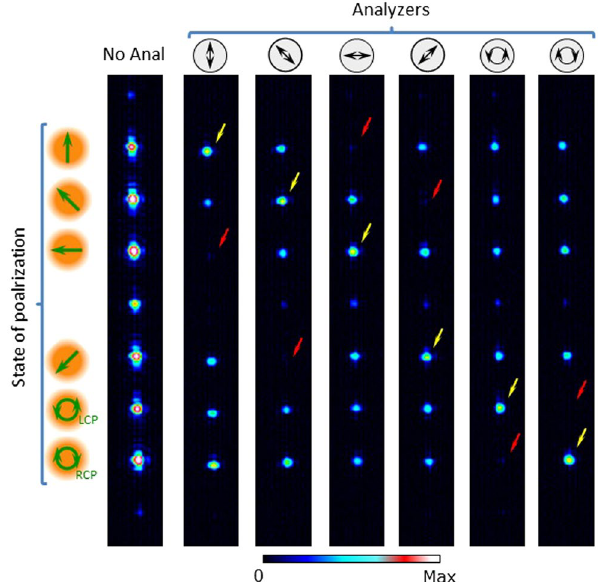
Figure 3. Experimental generation of a polarization diffraction grating generating 6 orders with different states of polarization. “No Anal” indicates the result without analyzer. The symbol on top indicates the analyzer used in the other cases. The yellow arrow points the bright spot indicating the order with the state of polarization coincident with the analyzer, while the red arrow points the null diffraction order corresponding to the orthogonal